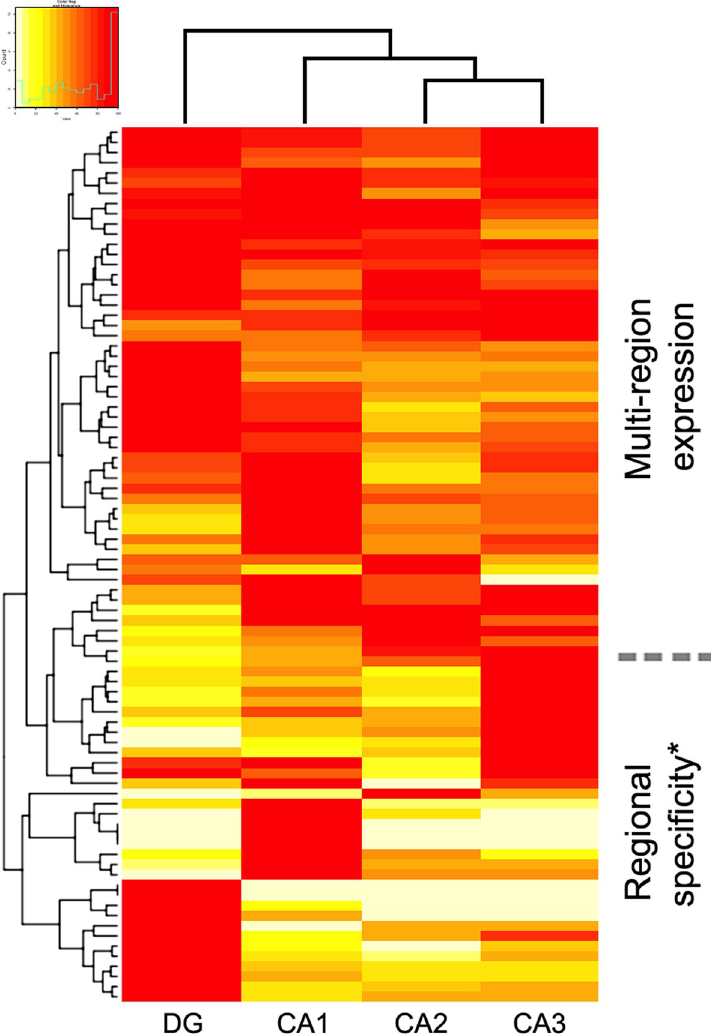
Fig 2. Subregional representation of 86 receptors expressed in mouse hippocampus (HPC). Data are normalized to the maximum expression level. � The data indicate that some receptors are somewhat restricted in their expression pattern to one subregion, whereas others are expressed in combinations of regions. Note: the depicted dendrograms (generated by heatmap.2) are not supported by statistical analysis versus alternative, competing dendrograms. There were significant positive correlations between CA2 and CA3, and significant negative correlations between CA1 and DG (Table D in S1 Appendix).